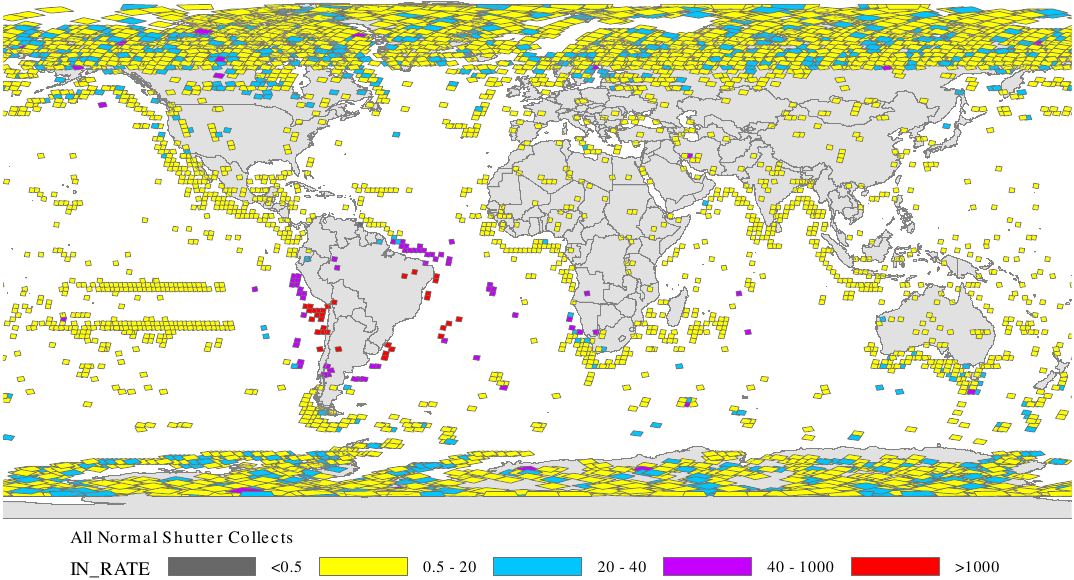
Figure 21. Rate of impulse noise occurrences for all normal shutter collects overlaid on a map showing increased impulse noise over South